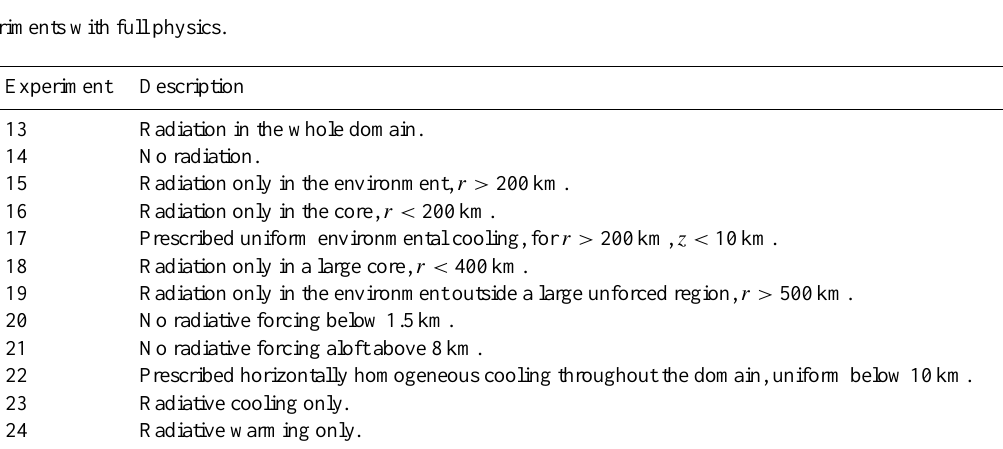
Table 4. Experiments with full physics. Experiment